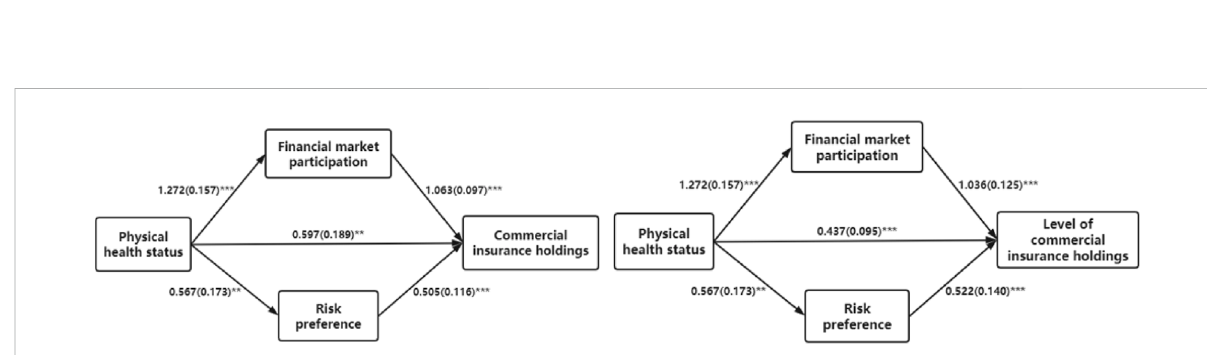
FIGURE 3 Results of the path analysis of physical health status and household commercial insurance holding behavior.